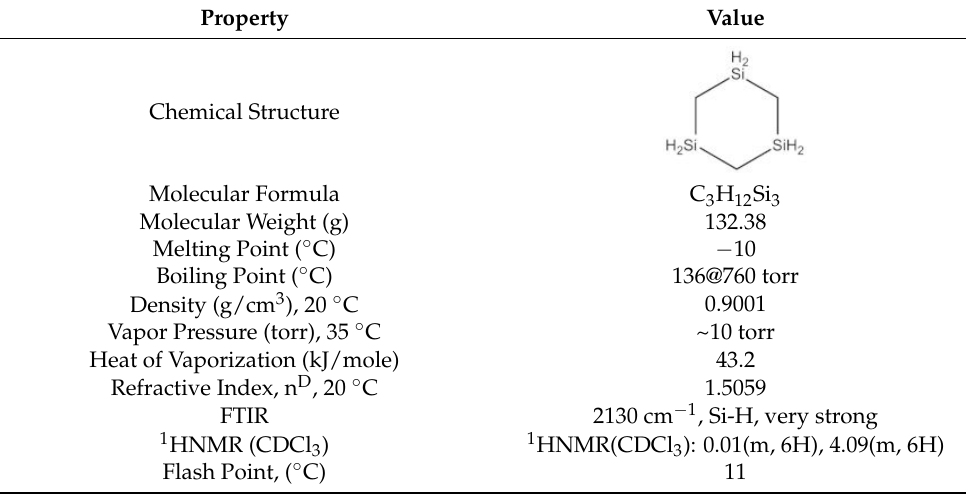
Table 1. Pertinent properties of Trisilacyclohexane